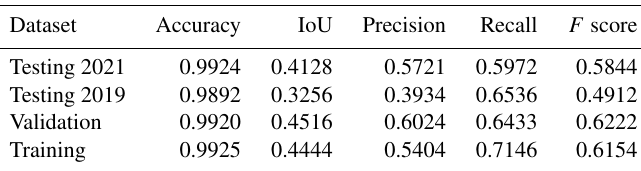
Table 5. Performance metrics for the green roof identification method, calculated based on building counts. For the full set of statistics for all folds, see the Appendix Table